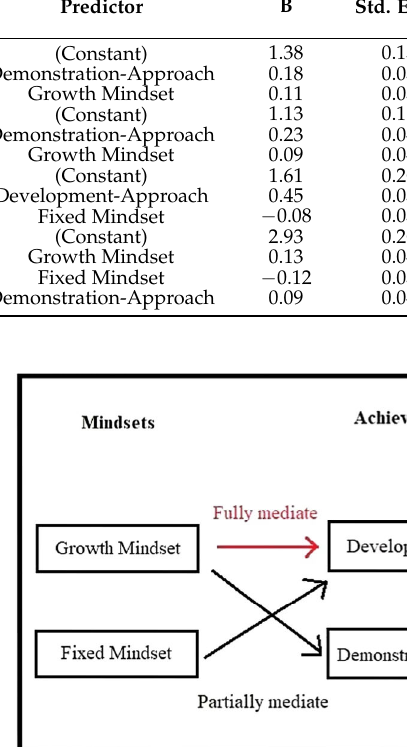
Figure 1. Mediating Role of Achievement Goals on Relationships Between Mindset and FSB.